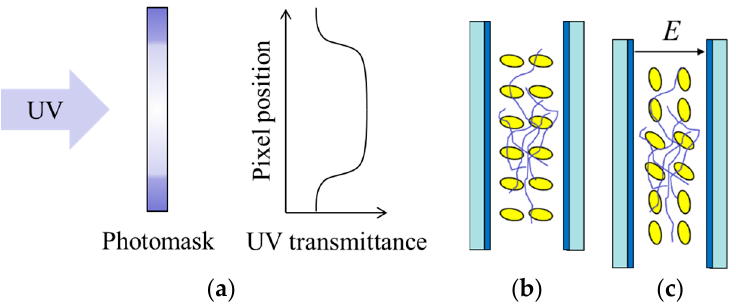
Figure 11. The proposed fabrication method of a PSLC LCoS with FFE-opposing features: ( a ) UV transmittance control by a gradient optical density photomask. ( b ) HG cell with inhomogeneous polymerization. ( c ) Spatially variant LC response to an external electric field.